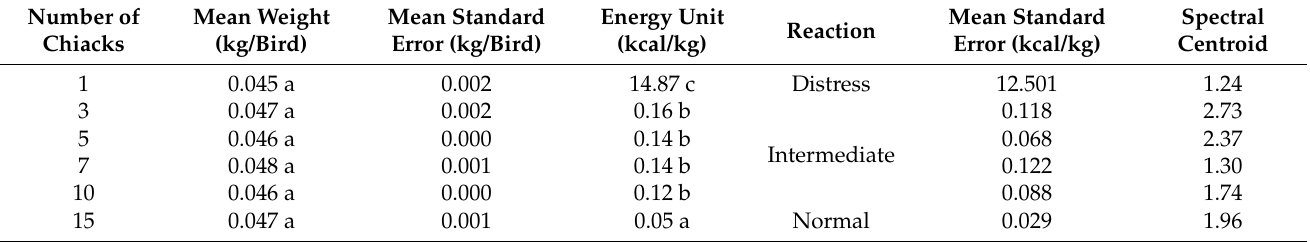
The values with the same letters do not differ ( p ≥ 0.05).